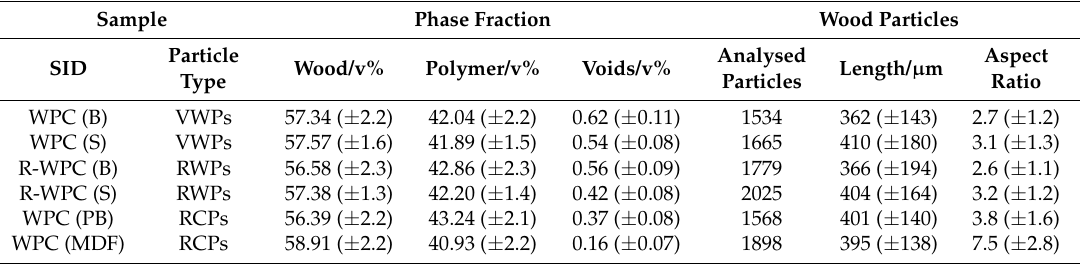
Table 3. Results of the quantification of different phases (polymer, wood and void space) located in the manufactured wood-polypropylene composites. Values represent the mean with standard deviation in parenthesis of three-dimensionally labelled phase fractions and wood particles, respectively. The phase fractions were listed based on their tomographic (voxel) fractions [v%]. Sample Phase Fraction Wood